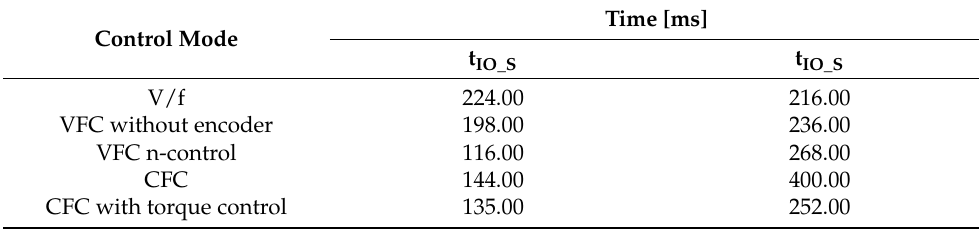
Table 6. Time characteristics of the output current (I O ) and the active current (I A ) in the transient state (without an external